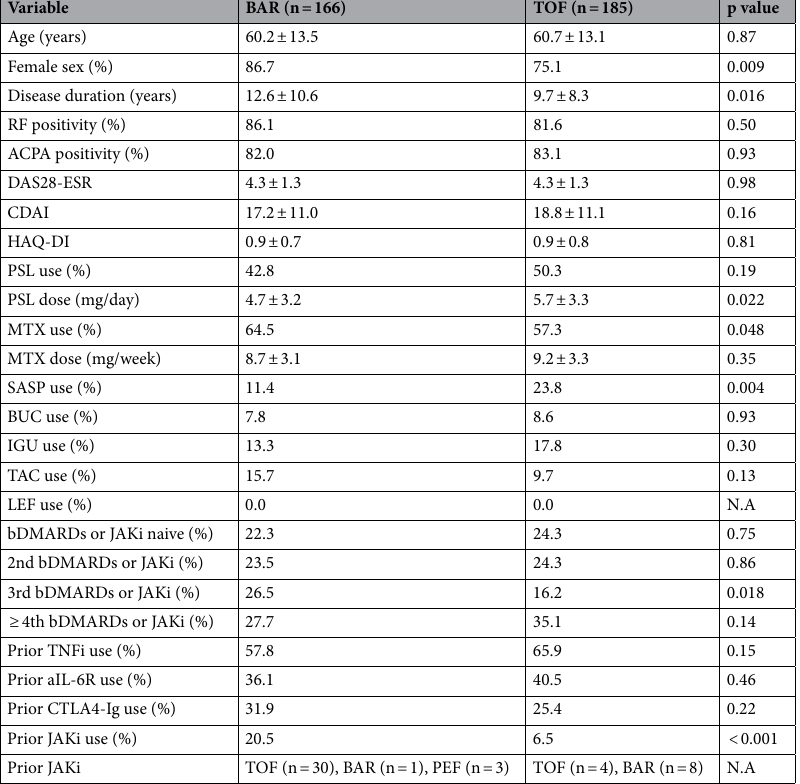
Table 1. Patients’ clinical characteristics at initiation of treatment with each agent. Values are presented as mean ± standard deviation or percentage. Differences between the groups were assessed by the Mann– Whitney U test or the chi-squared test. N.A. not applicable, BAR baricitinib, TOF tofacitinib, RF rheumatoid factor, ACPA anticyclic citrullinated peptide antibody, DAS28-ESR Disease Activity Score in 28 joints using erythrocyte sedimentation rate, CDAI clinical disease activity index, HAQ-DI Health Assessment Questionnaire disability index, PSL prednisolone, MTX methotrexate, SASP salazosulfapyridine,